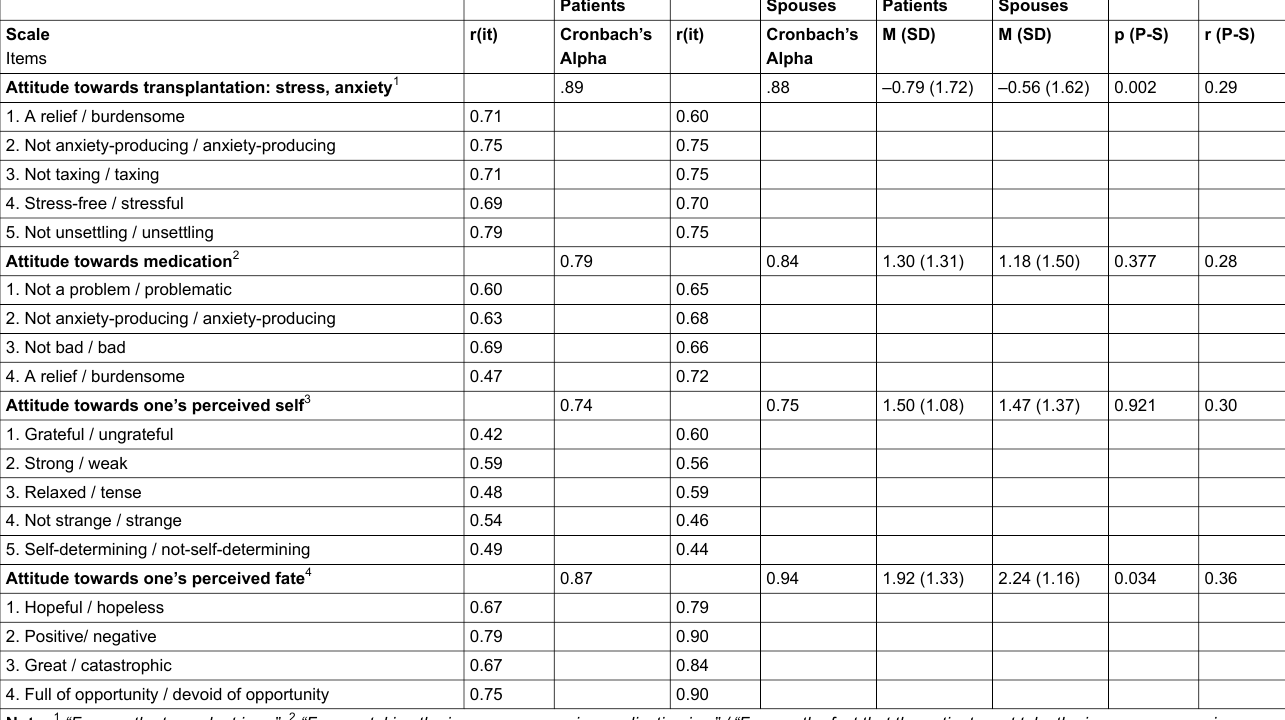
Table 3: Items of the ‘attitudes towards transplantation’ scales (ATTS): item-total correlations (r(it)), Cronbach’s Alpha, and scale means and standard deviations for patients (P) and their spouses (S), p-values for differences in scale means between patients and spouses, Pearson correlation (r) between patients and spouses (n =